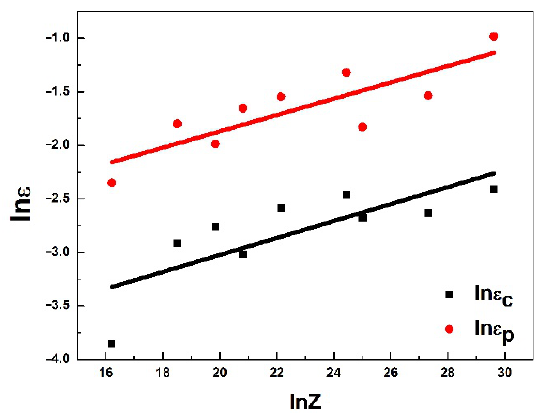
Figure 8. The characteristic points of the flow curves as a function of Z.